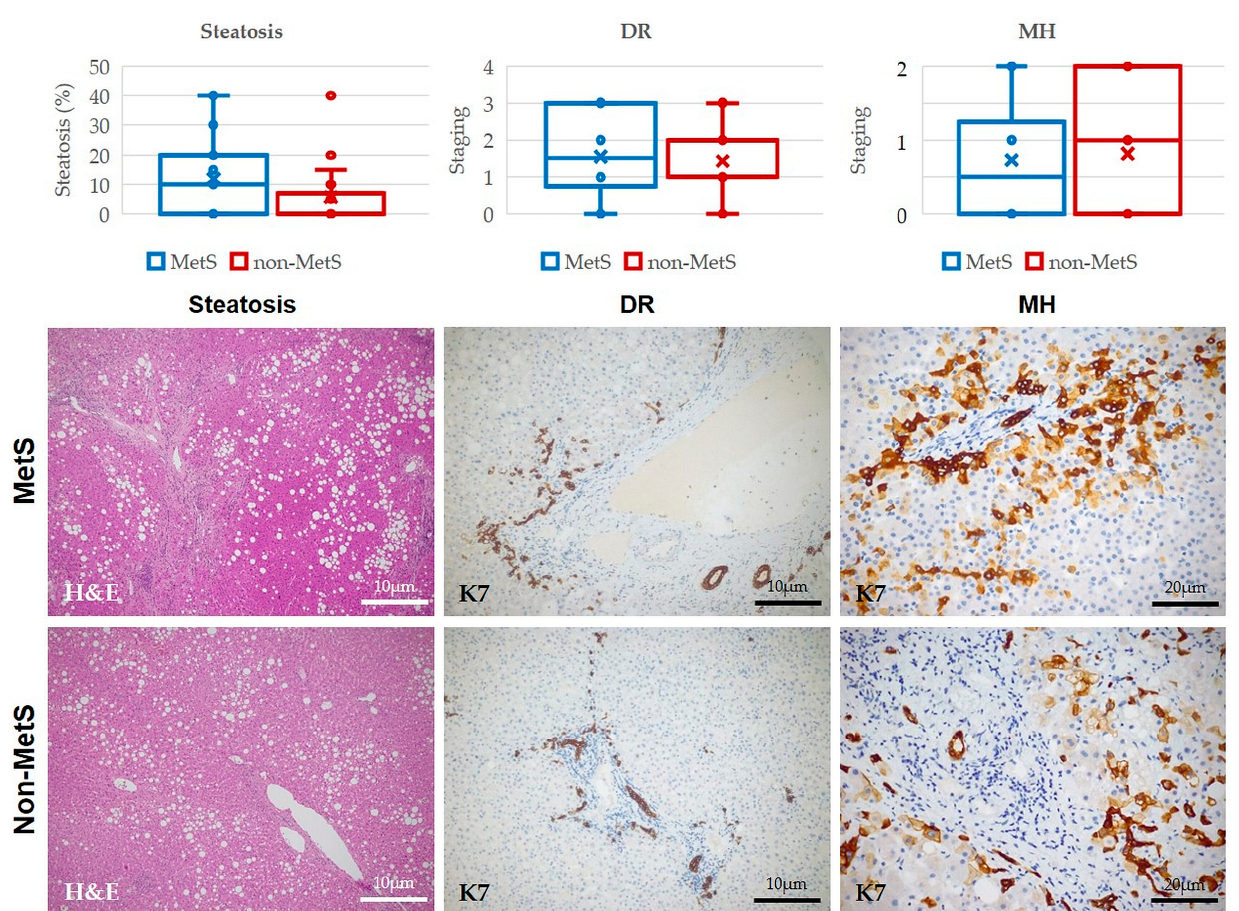
Figure 2. Presence and extent of steatosis, DR, and MHs in the peritumoral tissue of iCCA did not differ between MetS and non-MetS patients. Hematoxylin & Eosin (H&E) histological analysis of liver samples did not show significant differences in the % of steatosis between MetS and non-MetS peri-iCCA tissue. Similarly, by immunohistochemistry for cytokeratin 7 (K7), no significant differences in DR and MHs presence and extent were observed between MetS and non-MetS peri- iCCA tissue. Representative micrographs of peritumoral areas stained for H&E and K7 taken from surgical specimens of MetS and non-MetS patients are reported below the box & whiskers plots. p = N.S. (not significant) using 2-tailed T -test.